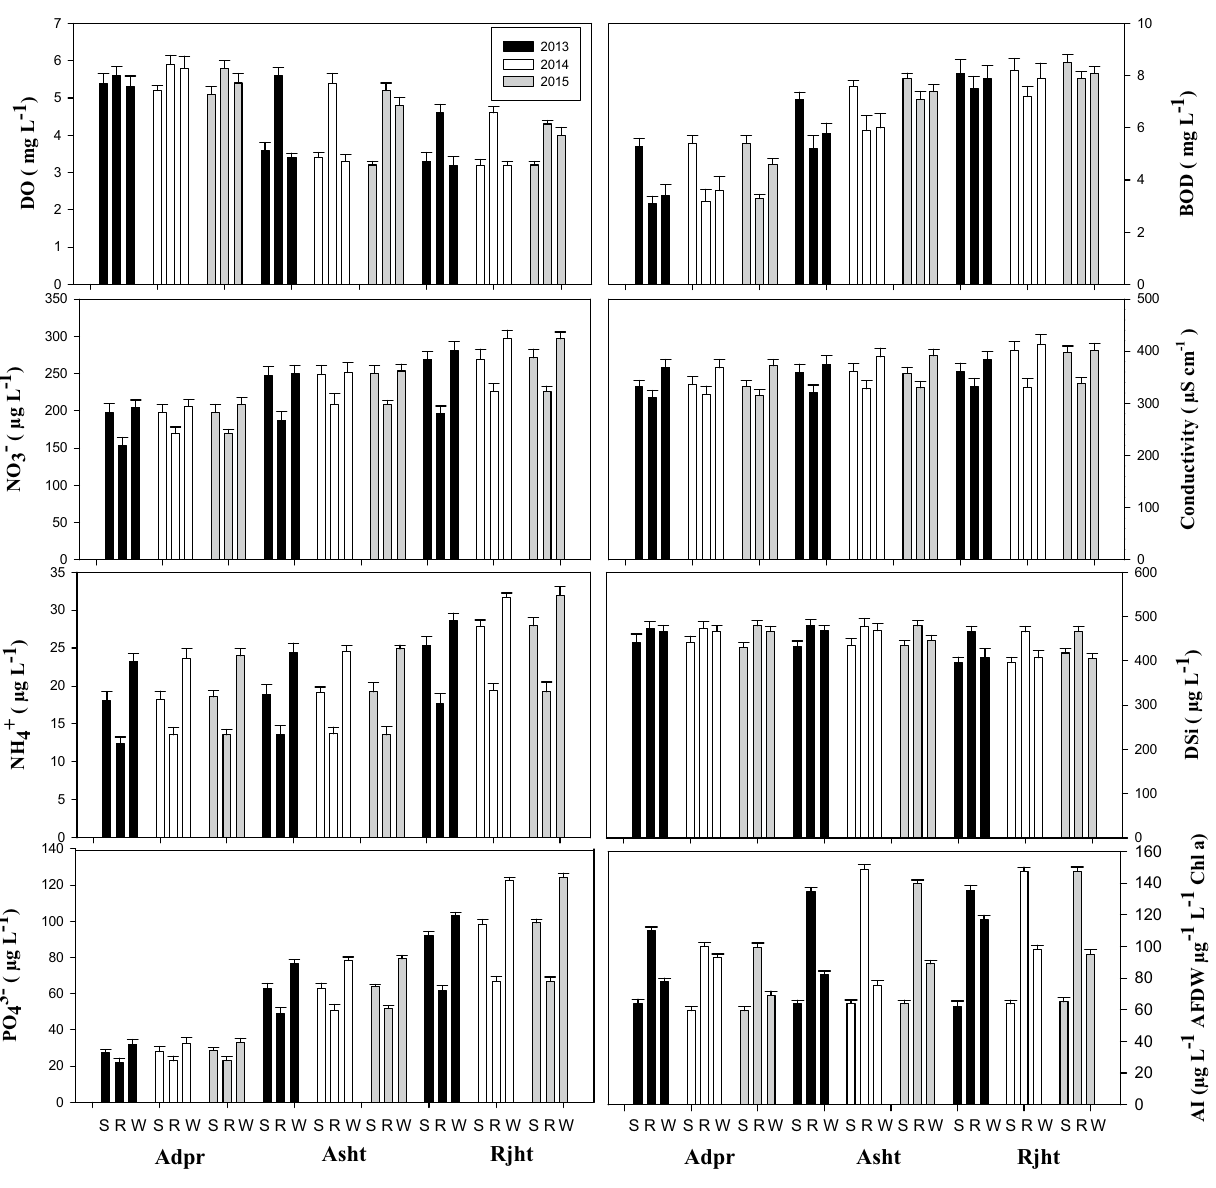
Fig. 3 Physicochemical characteristics and concentration of nutrients at study sites in the Ganga River. Values are mean ( n = 27) ± 1 SD. DO dis- solved oxygen, BOD biochemical oxygen demand, DSi dissolved silica, AI autotrophic index, S summer, R rainy season, W